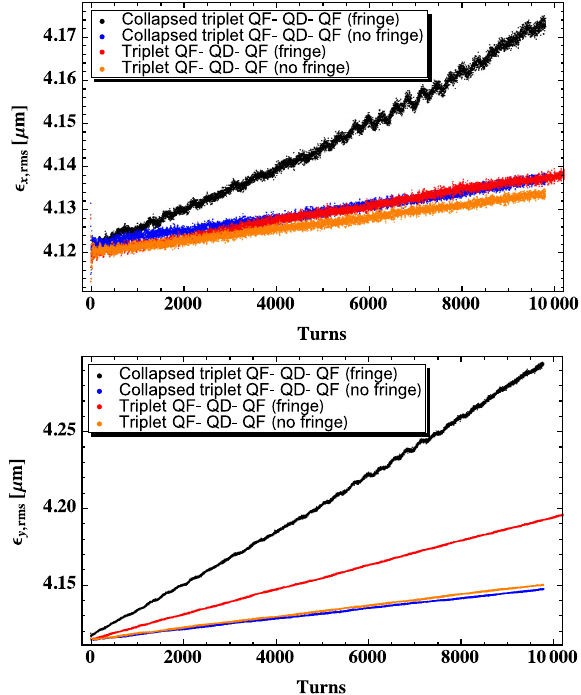
FIG. 3. Time evolution of horizontal (top) and vertical (bottom) rms emittance for the triplet and collapsed triplet cell lattice including fringe fields (fringe) and for the triplet cell lattice without fringe